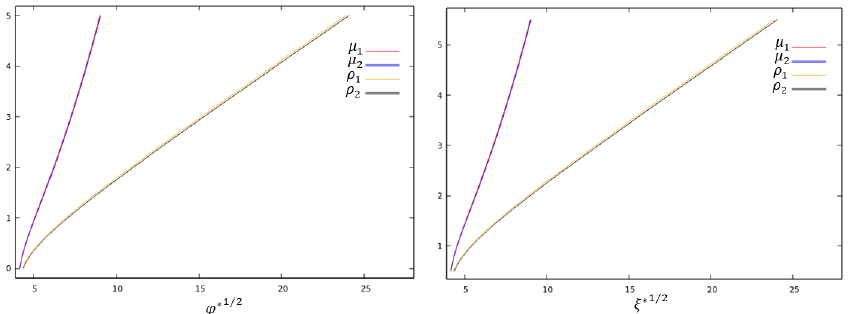
Figure 8. We show the chemical potentials µ i and charge densities ρ i , i = 1,2, respectively, as functions of the condensate value ϕ + ( left ) and ξ + ( right ) for the unbalanced case with (cid:101) = 0.9 and λ = 0.0